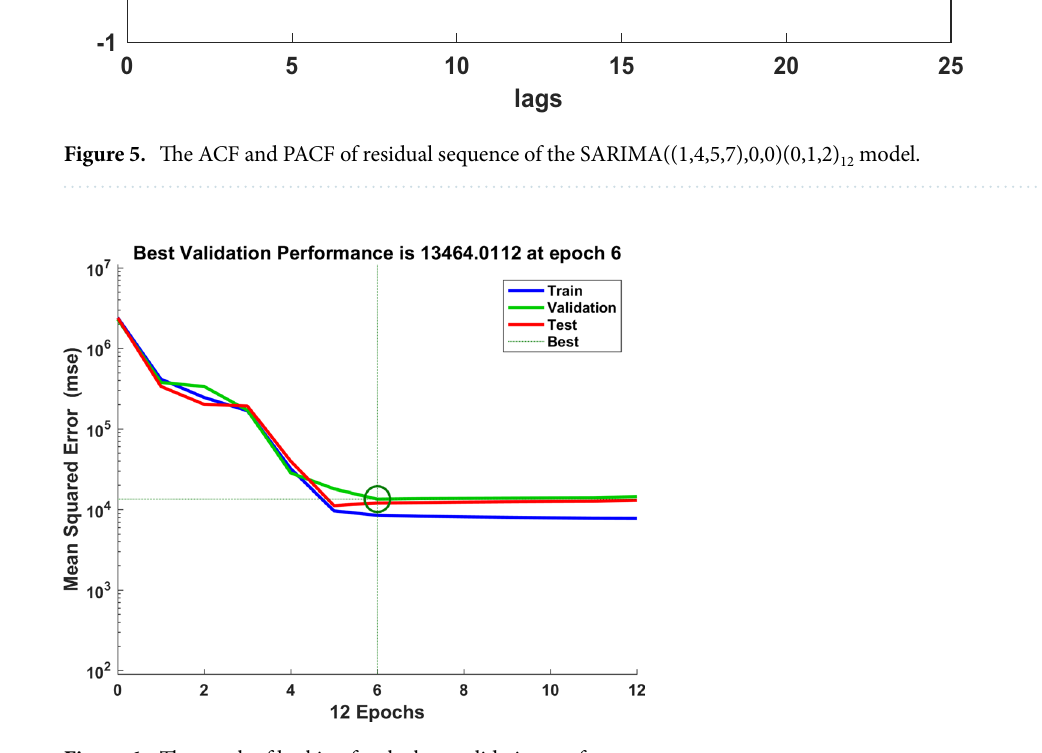
Figure 6. The graph of looking for the best validation